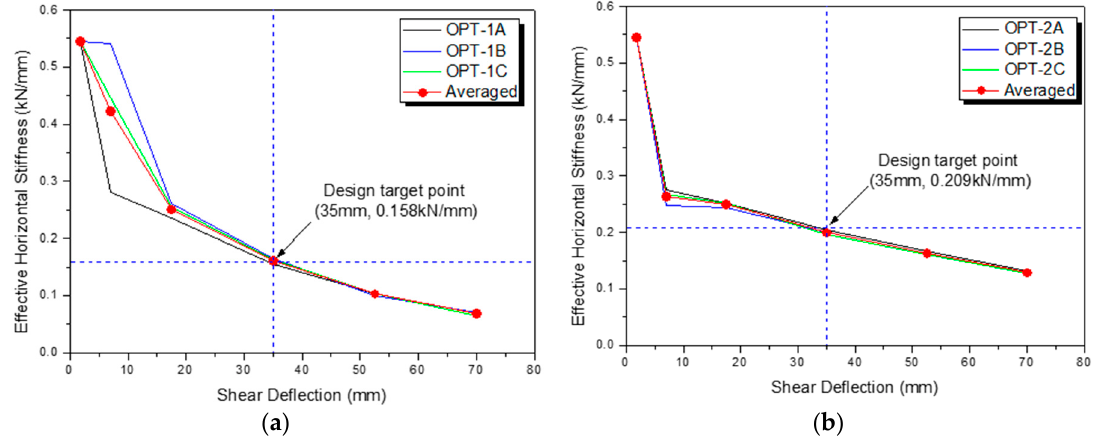
Figure 15. Determined effective horizontal stiffness from test data: ( a ) OPT-1; ( b ) OPT-2.